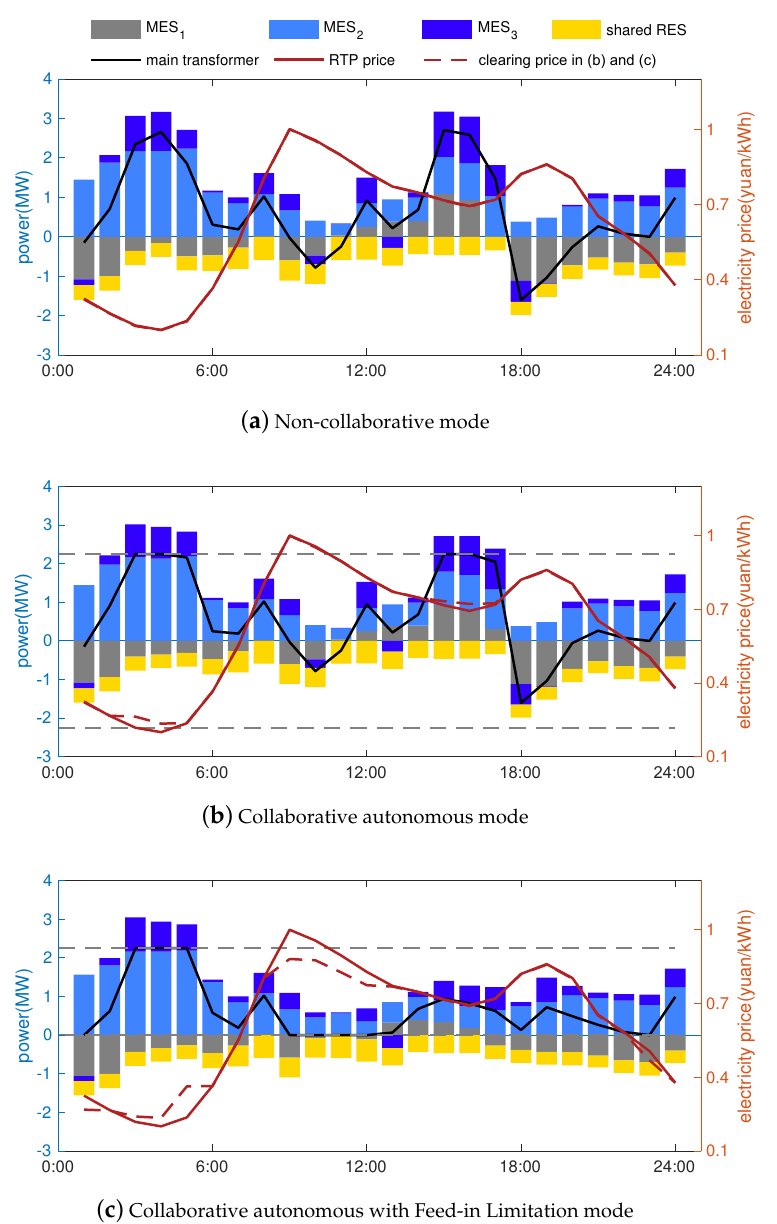
( c ) Collaborative autonomous with Feed-in Limitation mode Figure 6. Imported electricity of each MES and local